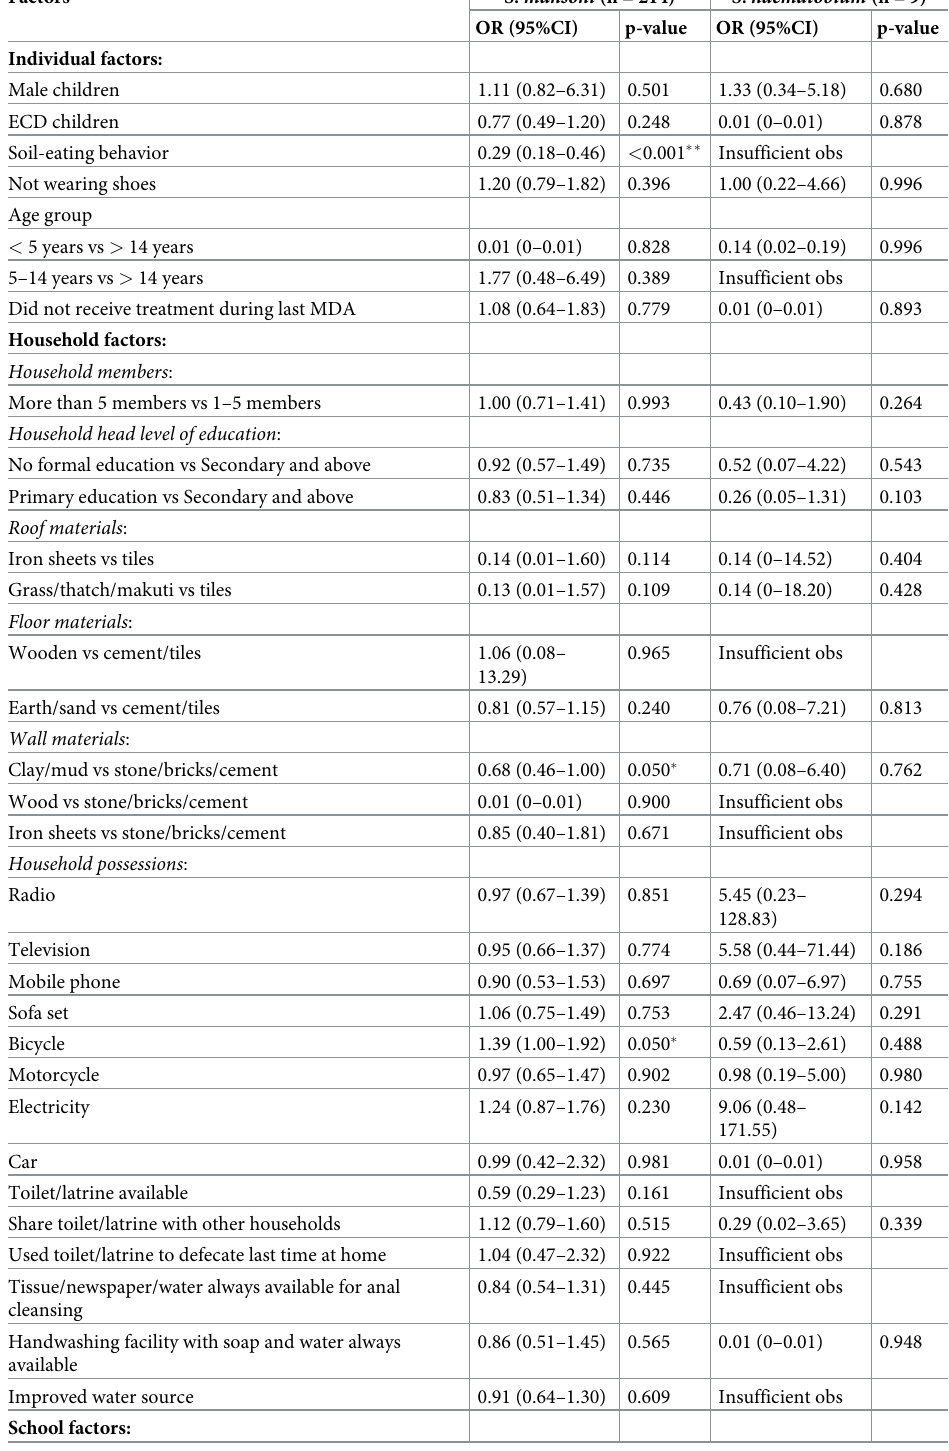
Table 12. Univariable associations between WASH conditions and schistosomiasis among school children in Kenya after five rounds of